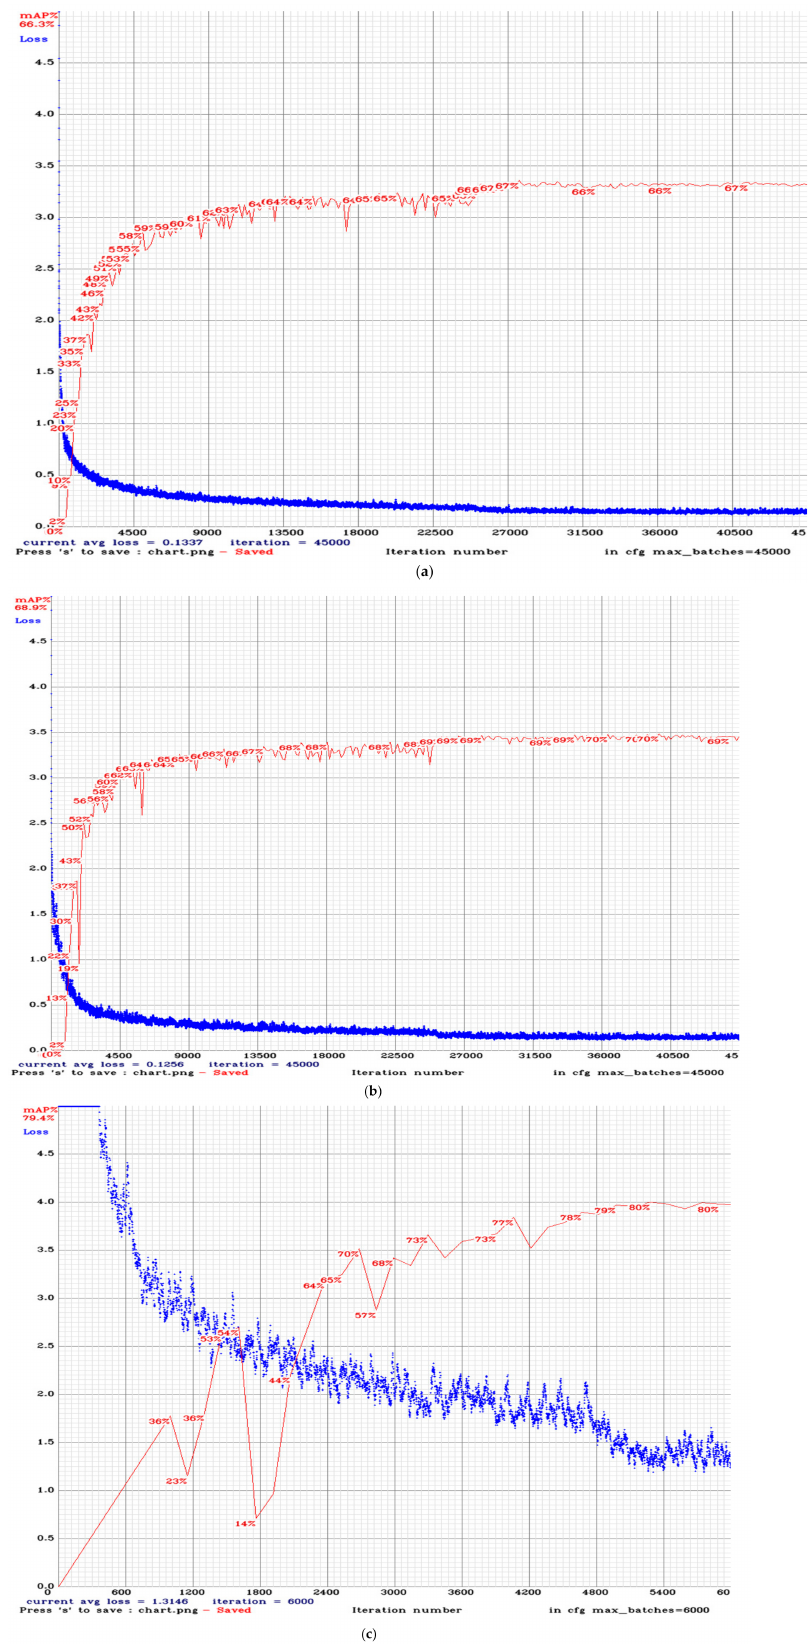
Figure 6. Training performance: ( a ) Densenet Yolo V2 CSP SPP; ( b ) Resnet Yolo V2 CSP SPP; ( c ) Yolo V4 CSP